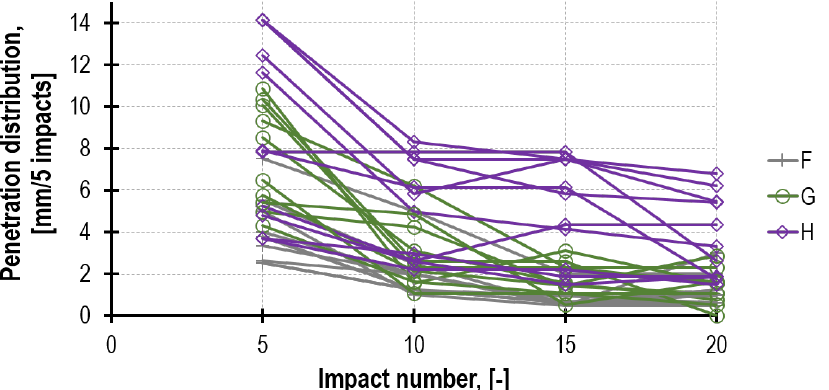
Figure 13. The penetration distribution divided into the mortar type demonstrated by outer surface measurements.